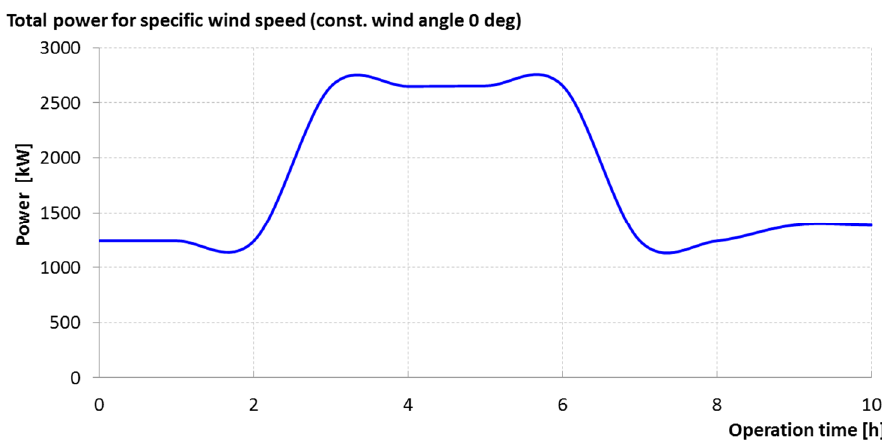
Figure 11. Power consumption by thrusters during positioning.